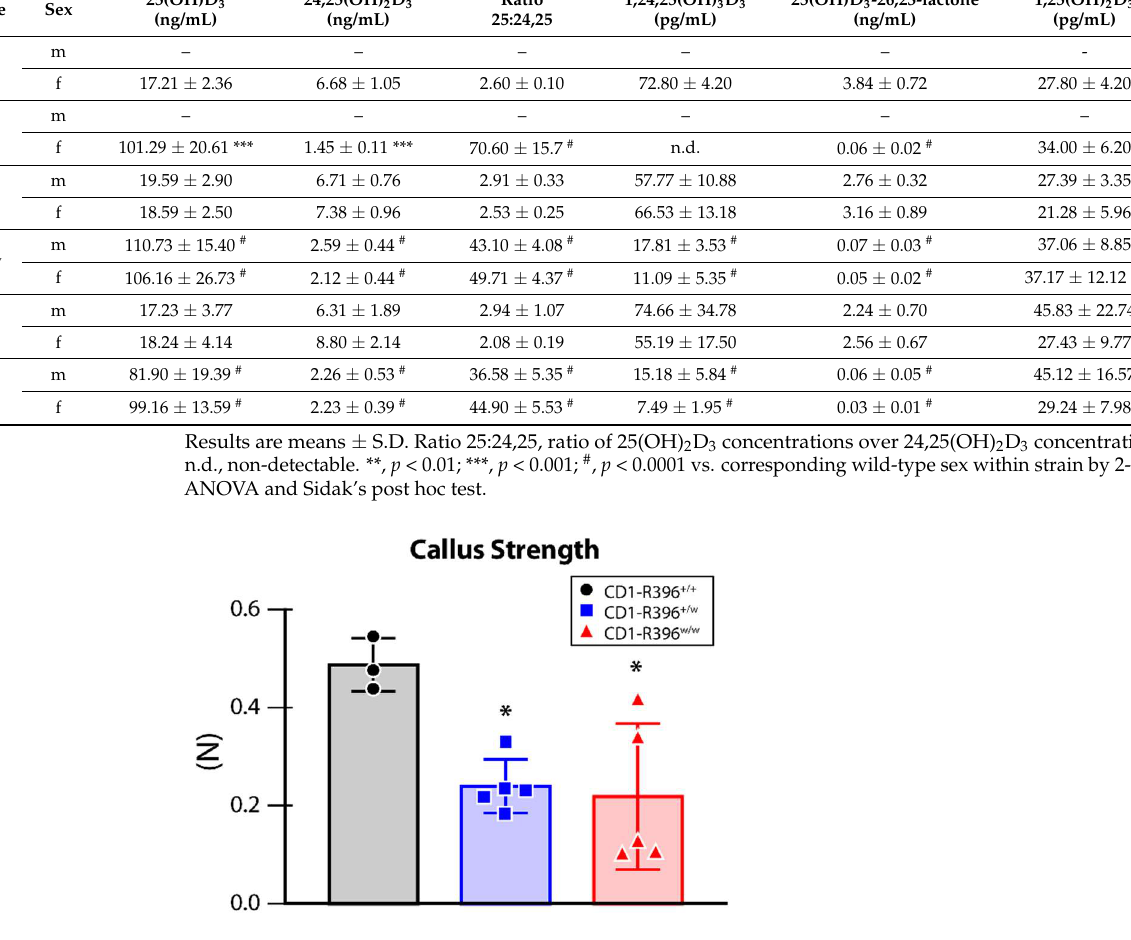
Figure 6. Impaired bone fracture healing in CD1-R396 w/w mutant animals. Callus strength (load at break) was calculated from the three-point bending test. *, p < 0.05 by one-way ANOVA with Tukey’s post hoc test.